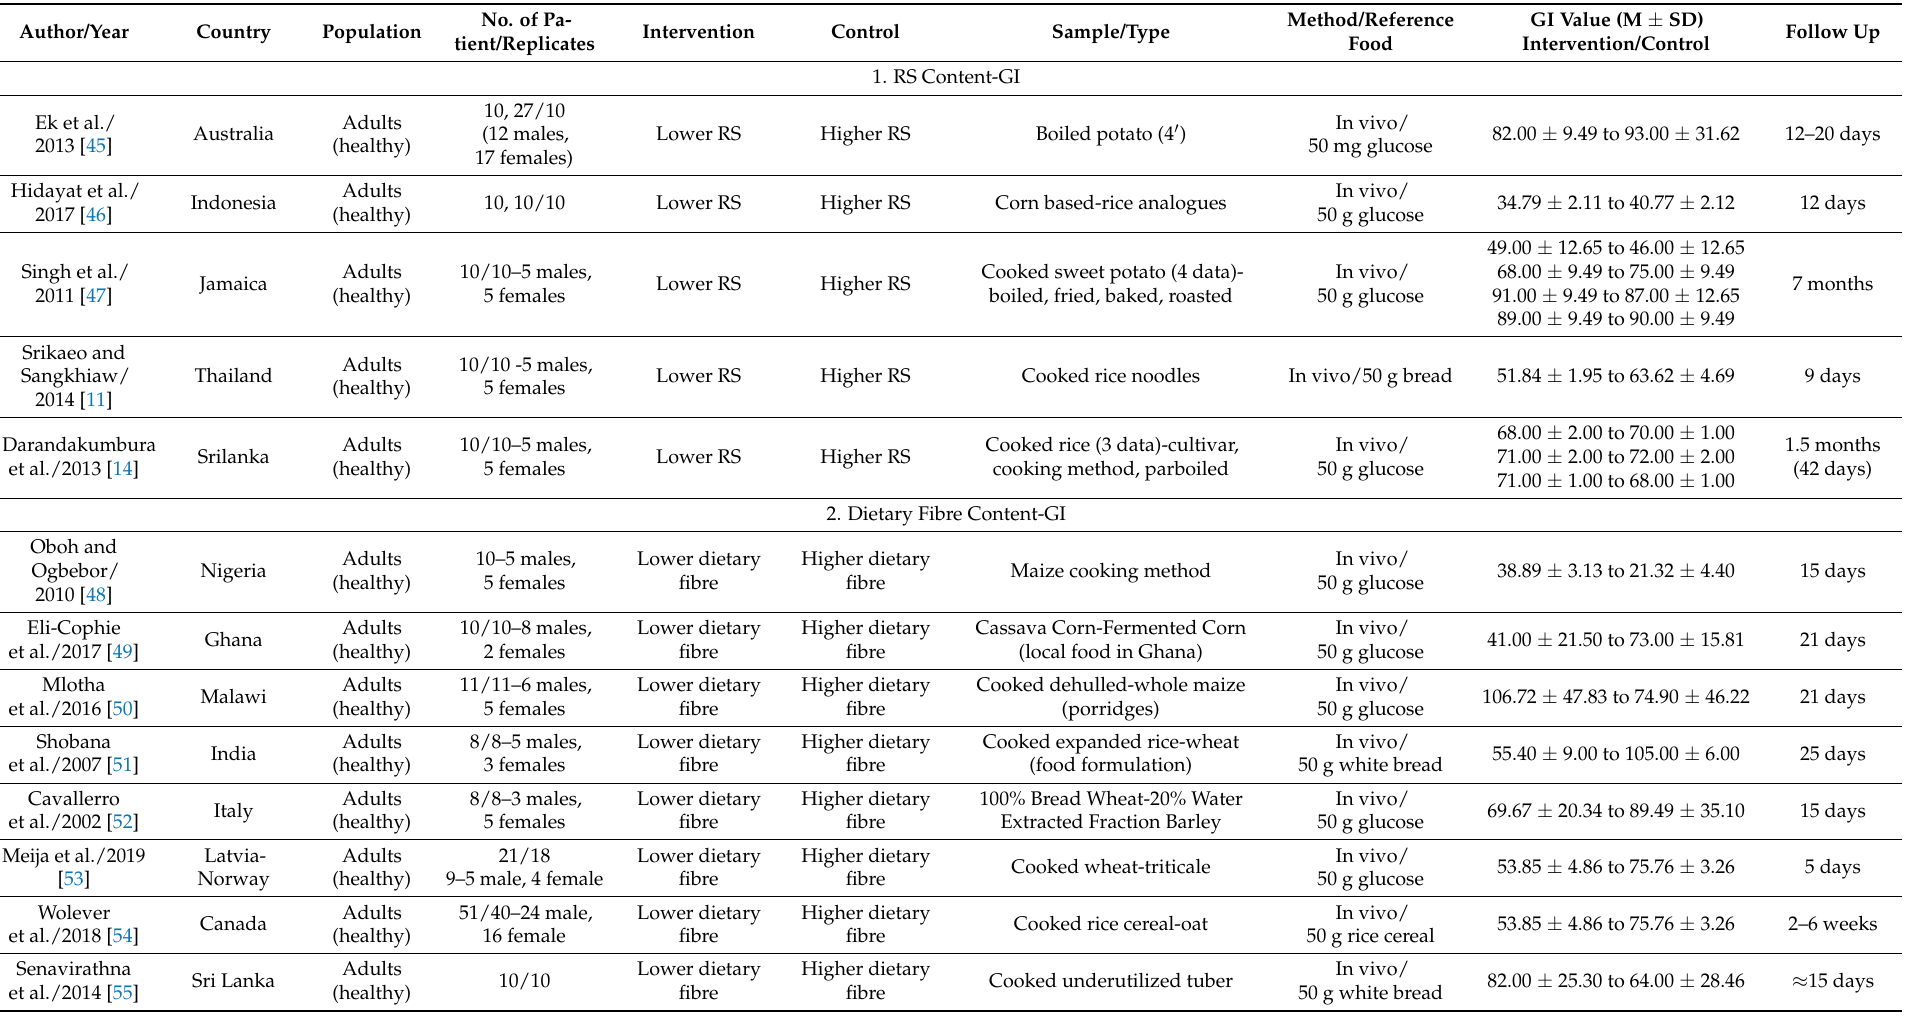
Table 3. Characteristics of in vivo studies included in the systematic review and meta-analysis. RS: resistant starch; GI: glycemic index; M: mean; SD: standard